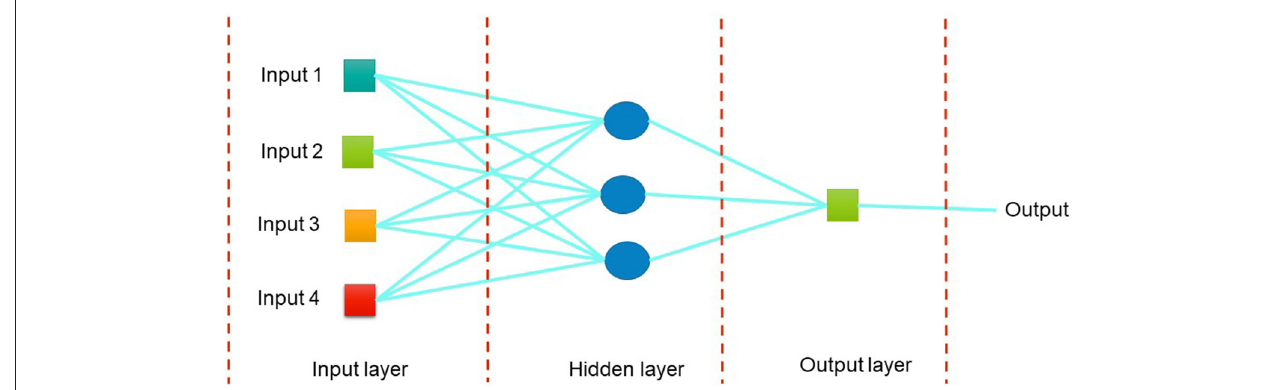
FIGURE 4 | Schematic diagram of ANN structure.